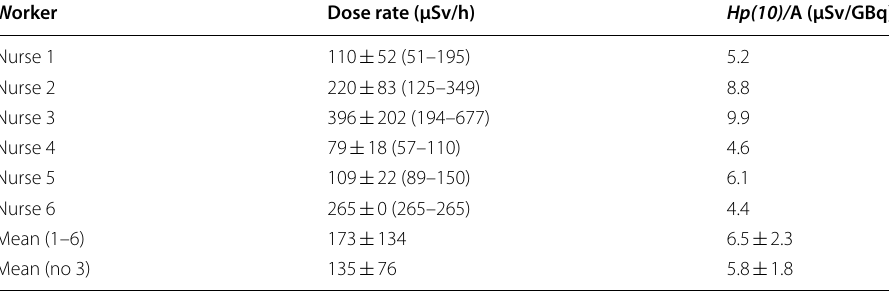
Dose rate (µSv/h) Hp(10)/ A